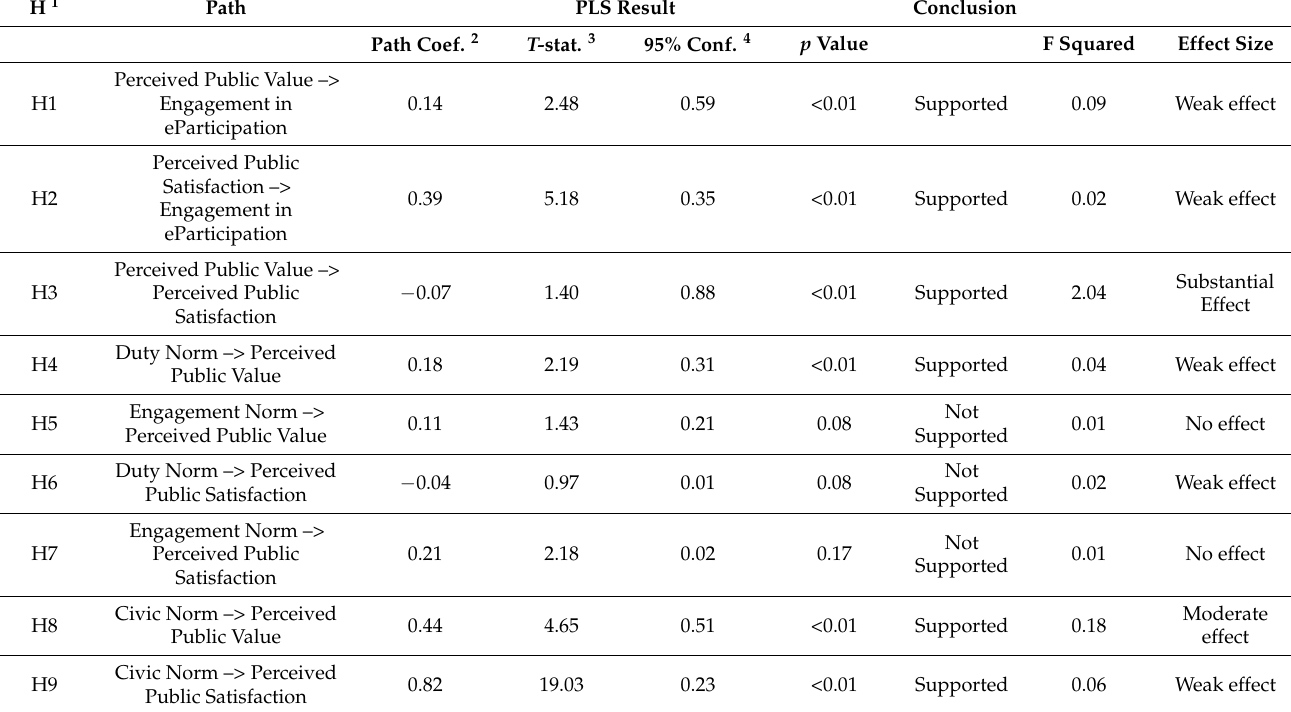
Table 6. Hypotheses test results.